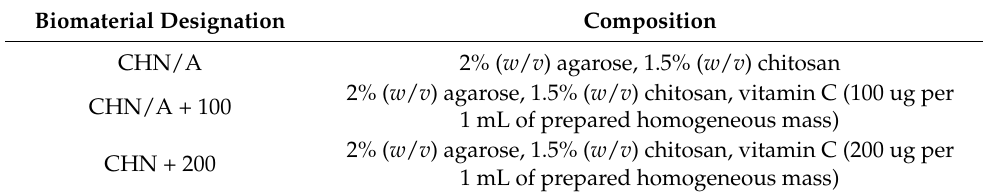
Table 1. Biomaterials designations and their